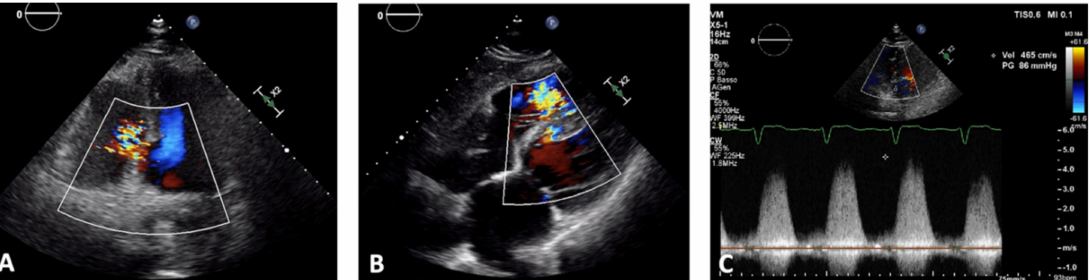
Figure 2. Ventricular septal defect (VSD) in a patient diagnosed with subacute myocardial infarction 3 days after reperfusion of right coronary artery. ( A ) Apical four-chamber view shows presence of a posterior VSD. Color Doppler mode demonstrated a high-velocity flow through the neck of the VSD, which corresponds to left-to-right shunt. ( B ) Subcostal view confirmed presence of a serpiginous posterior VSD with left-to-right shunt. ( C ) Continuous-wave Doppler imaging showed presence of a high velocity shunt, although underestimated because of non-completely parallel positioning of doppler-marker as respect to flow